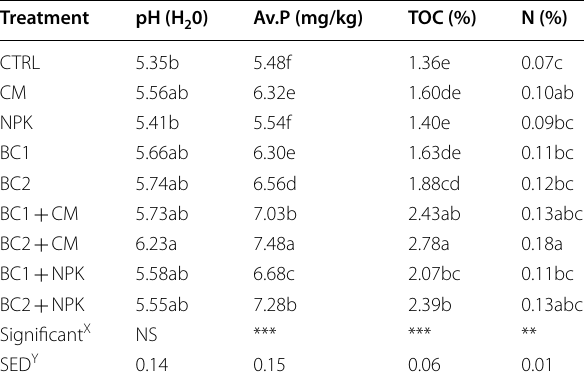
Table 4 Residual effects of biochar farmyard, compost